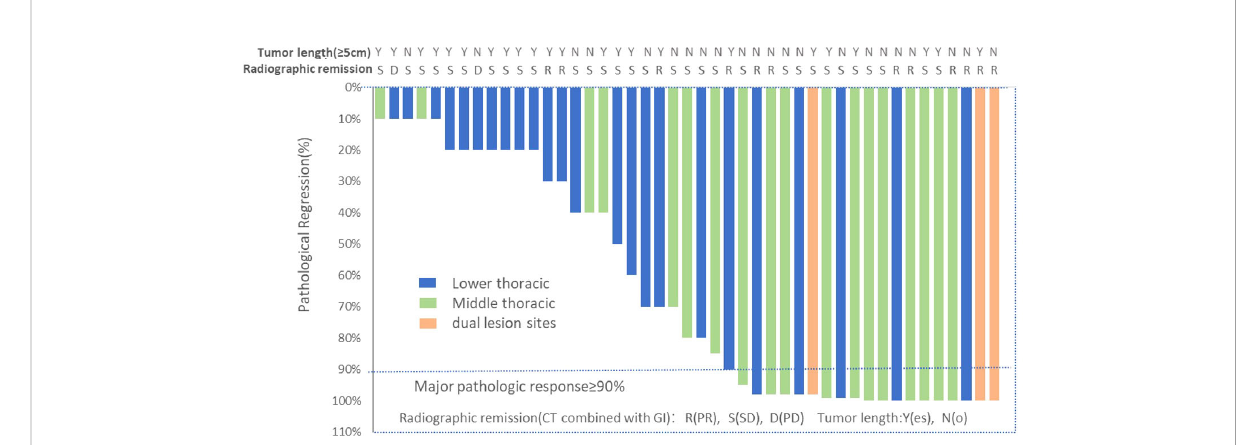
FIGURE 3 Waterfall plot of pathological tumor regression in the population (N=45). Each bar represents one patient. The upper column shows clinical characteristics and radiological